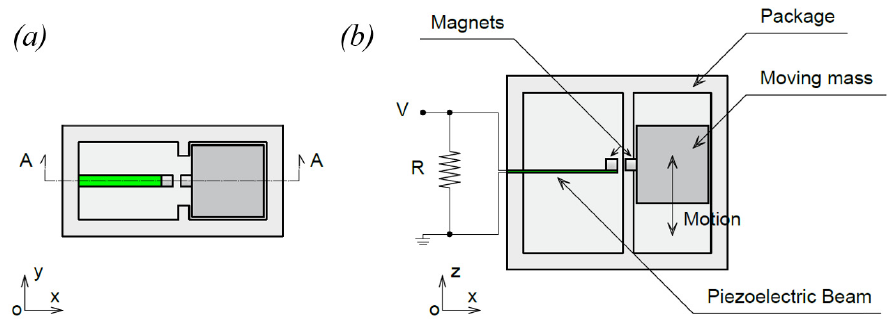
Figure 1. Conceptual illustration of the device: ( a ) xy plane view ( b ) section A-A view, plane xz.